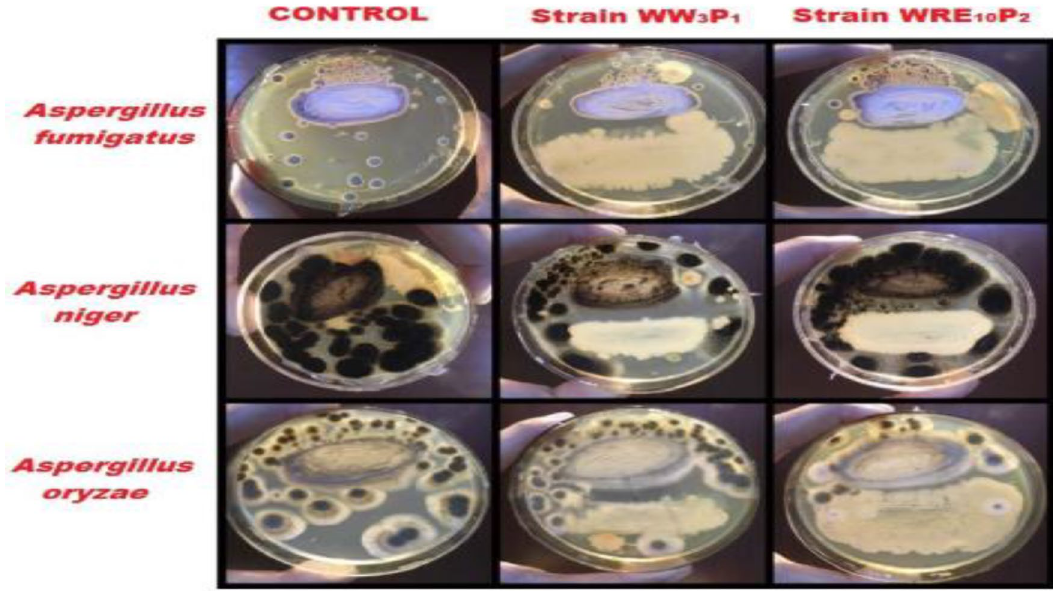
Fig. 3 Inhibitory action of isolates towards Aspergillus